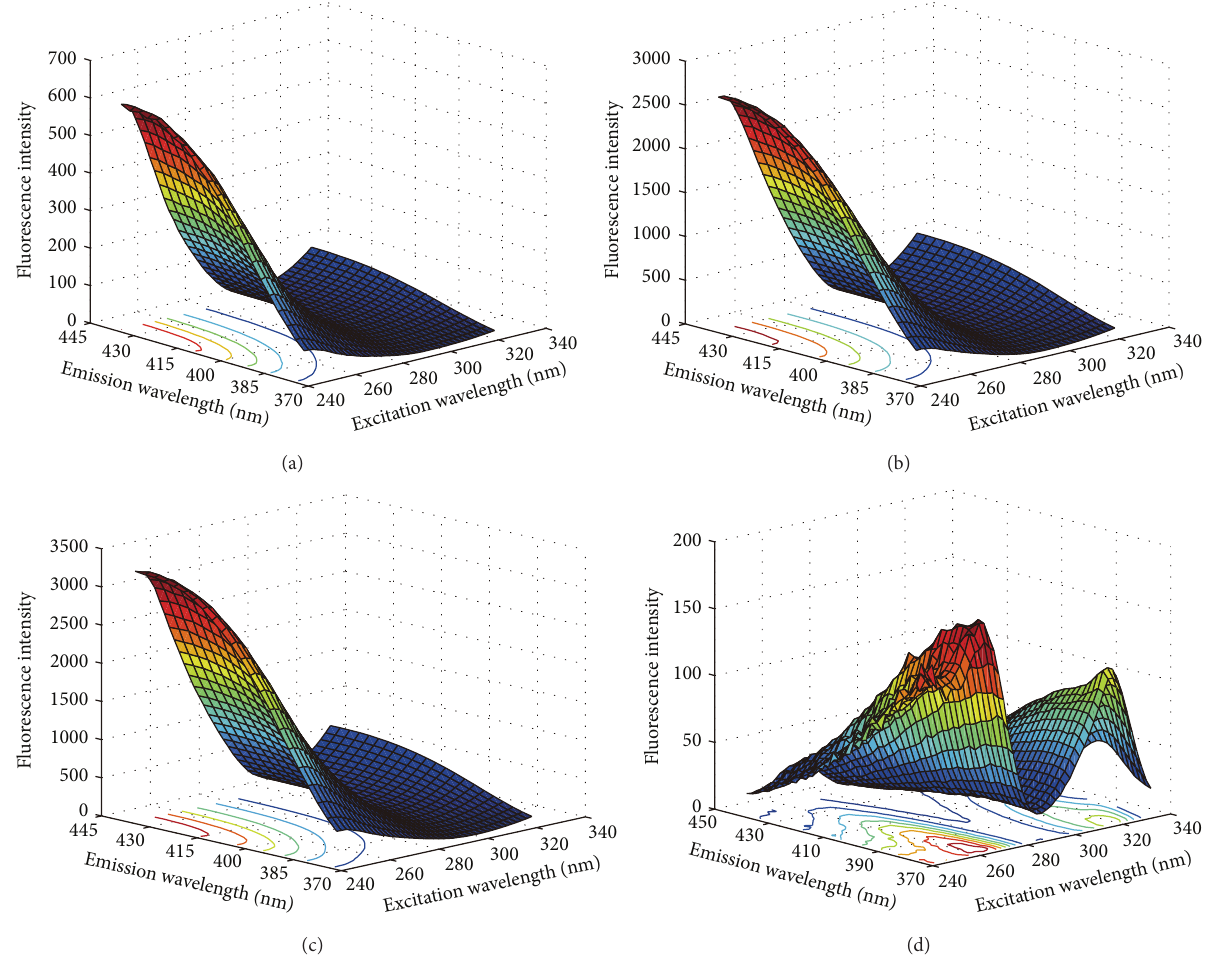
Figure 2: Three-dimensional plots of the excitation-emission matrix fluorescence spectra: (a) 9.11 𝜇 g/mL pure amlodipine besylate; (b) 9.11 𝜇 g/mL amlodipine besylate and 50 𝜇 L SDS; (c) 9.11 𝜇 g/mL amlodipine besylate and 50 𝜇 L SDS in human plasma; (d) blank human plasma. Table 2: Determination of valsartan and amlodipine besylate in test samples using two algorithms. Analytes